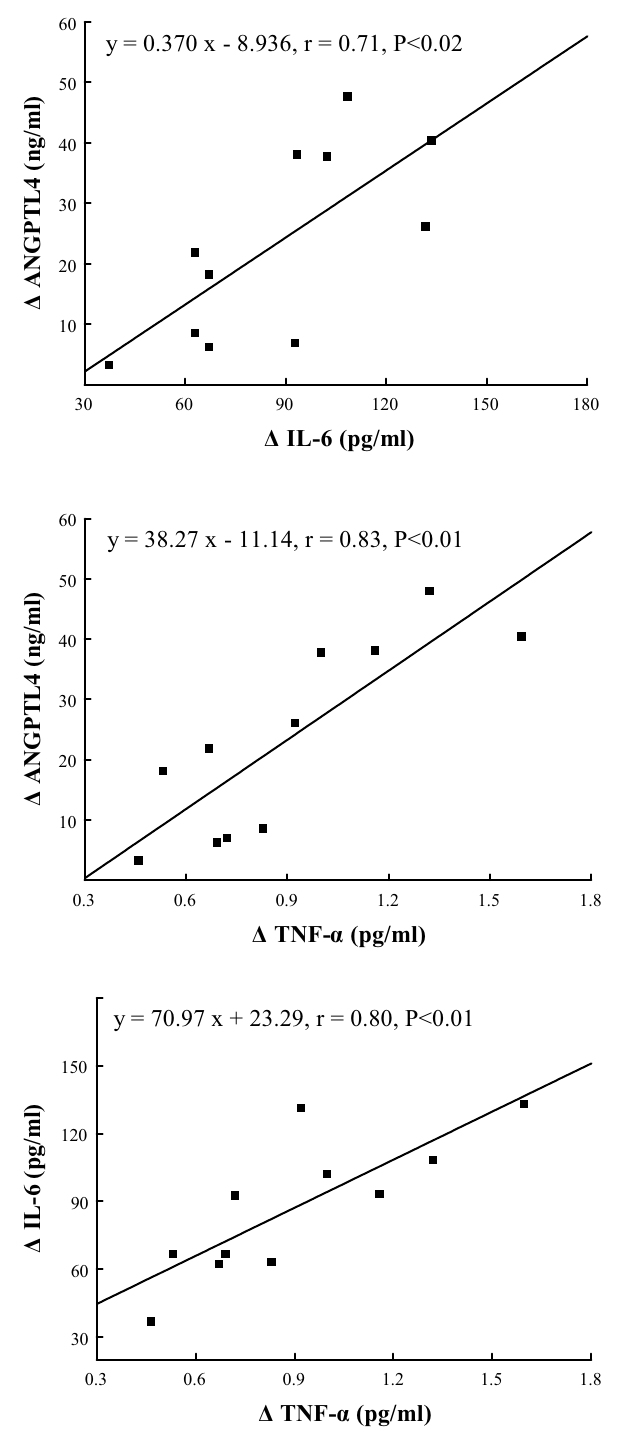
Figure 3. The relationships between exercise-induced changes in plasma concentration of angiopoietin-like protein 4 (ANGPTL4) and those of plasma interleukin 6 (IL-6), tumor necrosis factor-α (TNF-α) as well as between exercise-induced changes in plasma concentration of IL-6 and